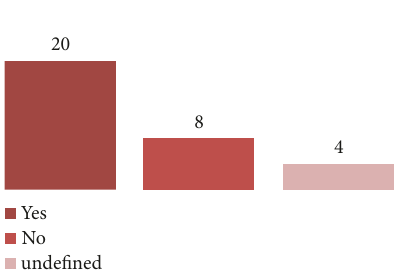
Figure 8: The system has the possibility of remote